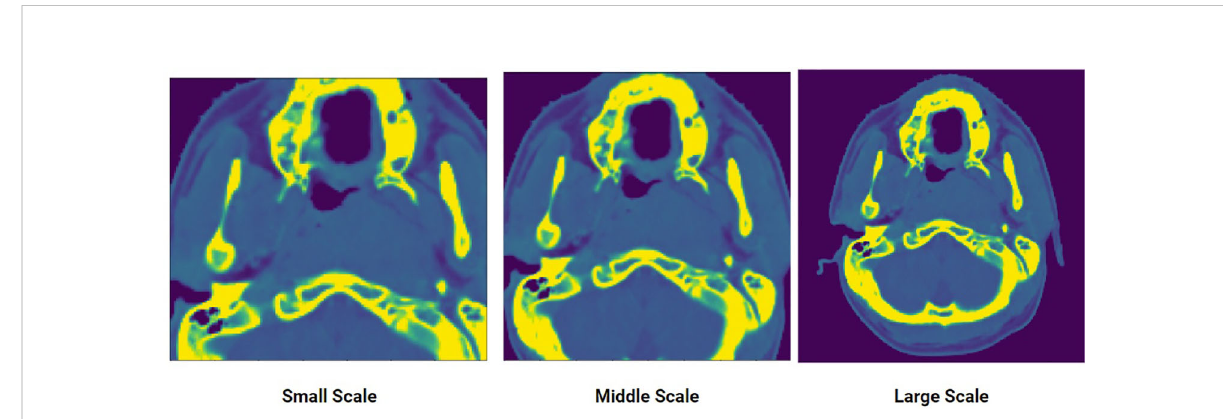
FIGURE 2 An input CT scan showing three different scales of the same scan: small, middle, large. Five scales were generated to create the multi-scale training